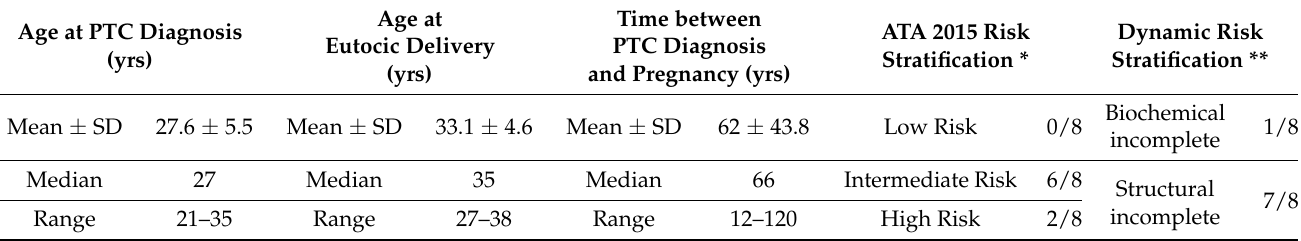
Table 1. Risk classifications and age data at different time points assessed in PTCs